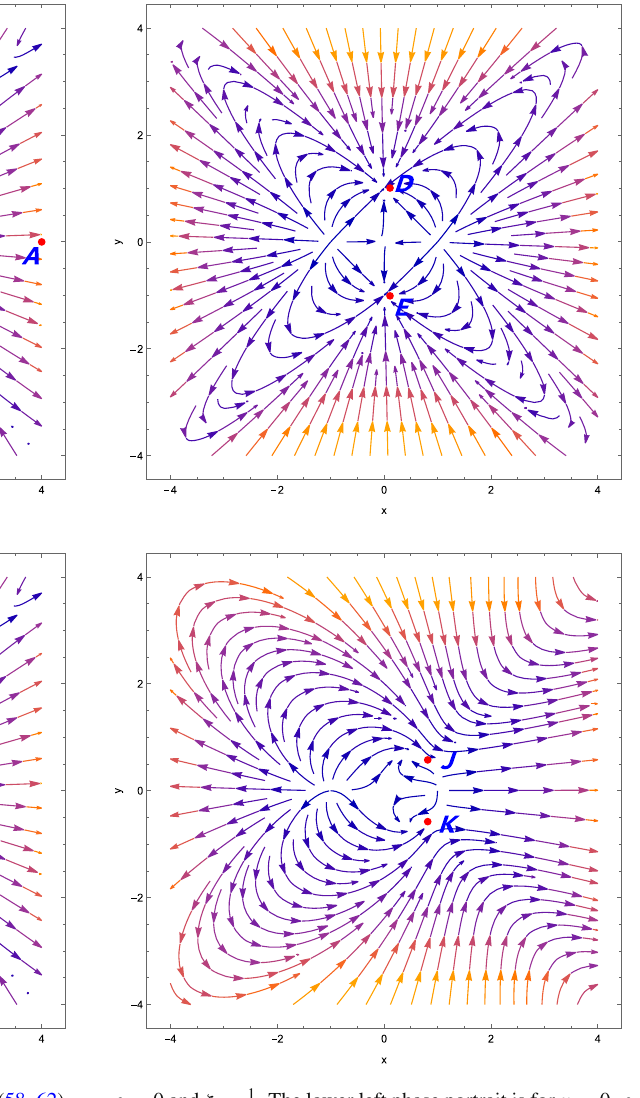
Fig. 2 Phase portrait for dynamical system presented in Eqs. (58–62), the upper left plot is for the parametric value u = 0, ρ = 0, τ = 1 (cid:13) 2 and λ = . The upper right plot is for the parameteric values u = 0, 9